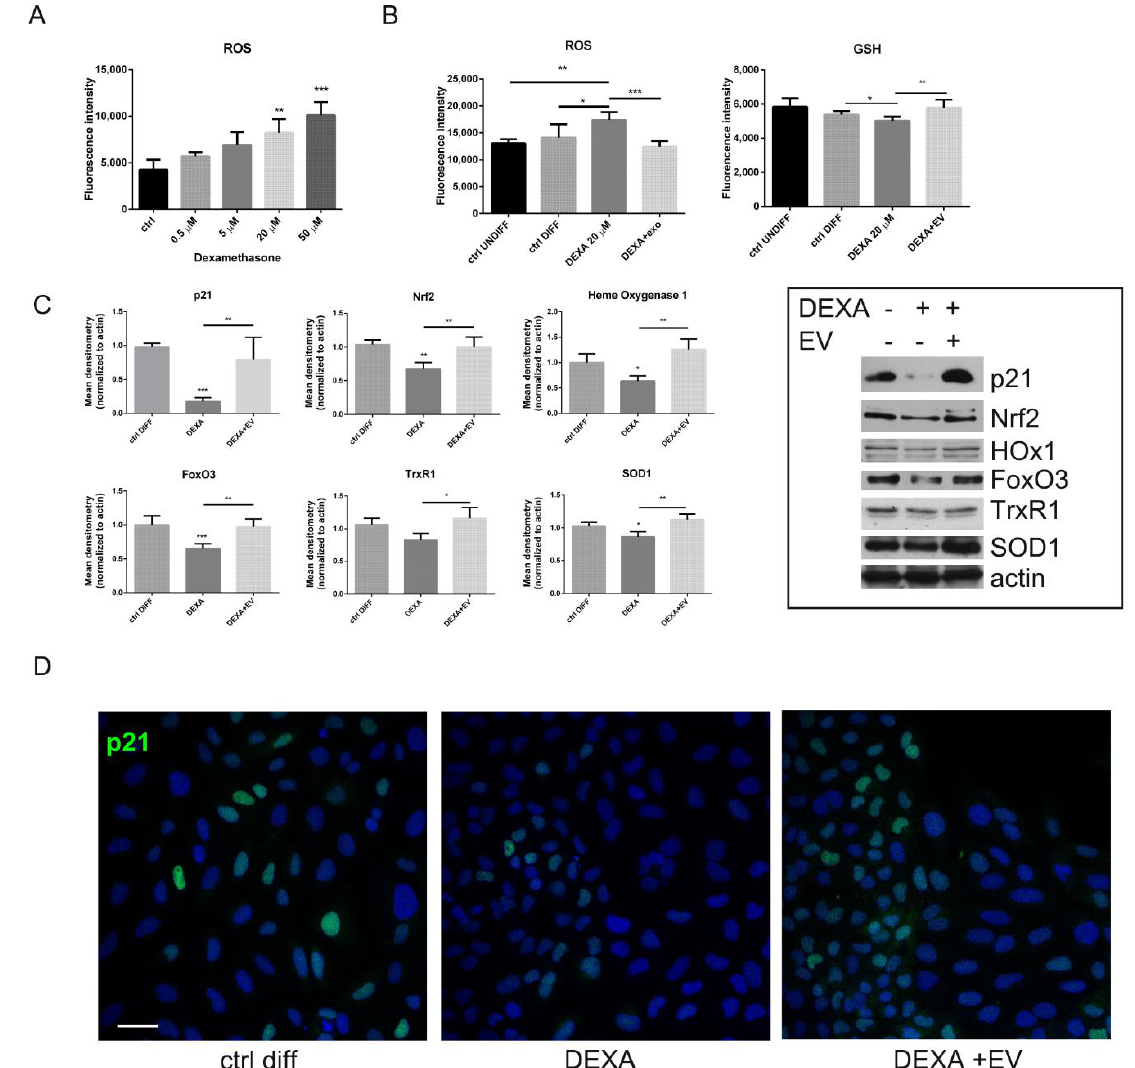
Figure 3. Effect of AFCS-EV supplementation on reactive oxygen species (ROS) modulation in HOB treated or not with Dexamethasone. ( A) —Graph showing ROS assay of HOB cells treated with increasing concentration of DEXA. ** p value < 0.01; *** p value < 0.001. ( B) —ROS and GSH content was measured with fluorescent probes, after AFSC-EV exposure and DEXA treatment. * p value < 0.05; ** p value < 0.01; *** p value < 0.001. ( C) —Western blot analysis of total lysate of HOB, treated or not with AFSC-EV, then exposed to DEXA. Immunoblot were performed with the indicated primary antibodies. The graphs represent the mean ± SD of densitometric analysis of three experiments, normalized to actin values. * p value < 0.05; ** p value < 0.01; *** p value < 0.001. ( D) —Representative images with DAPI (blue) and p21 (green) signals of HOB cells incubated or not with DEXA and EV are shown. Scale bar = 10 µm.